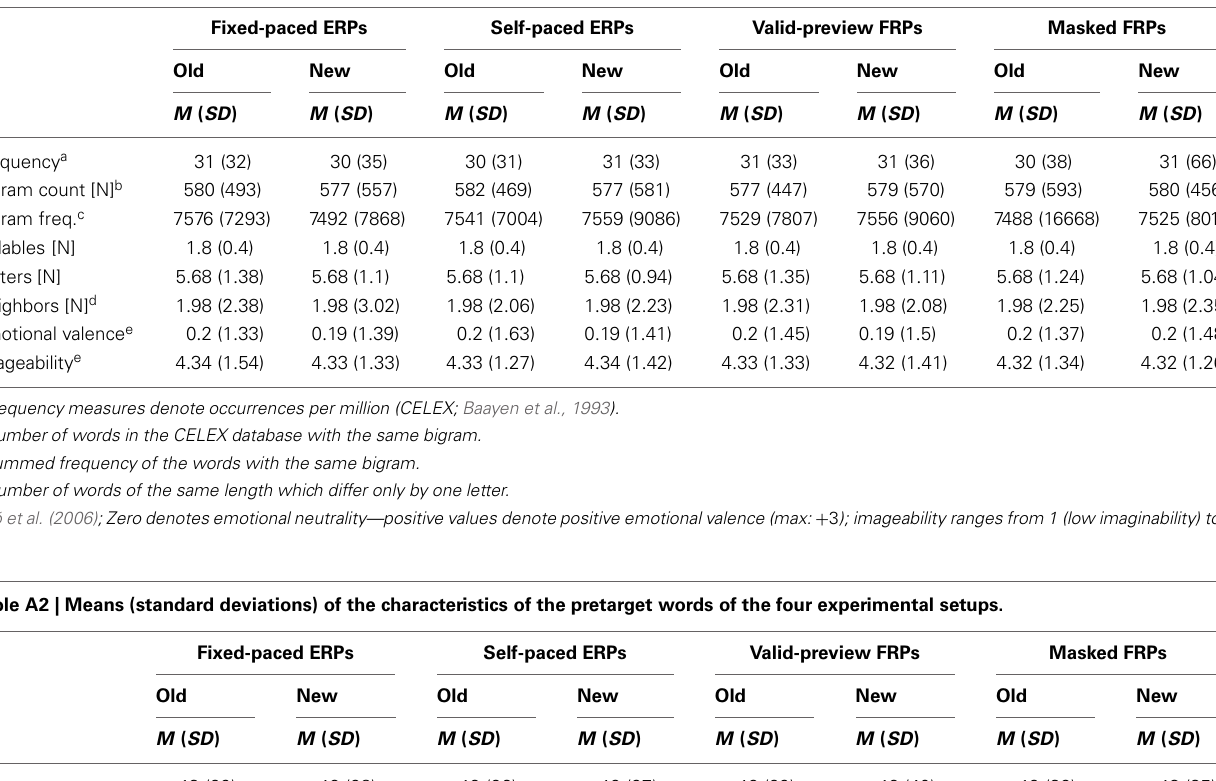
Table A1 | Means (standard deviations) of the characteristics of the “old” vs. “new” target words separately for each of the four experimental setups.